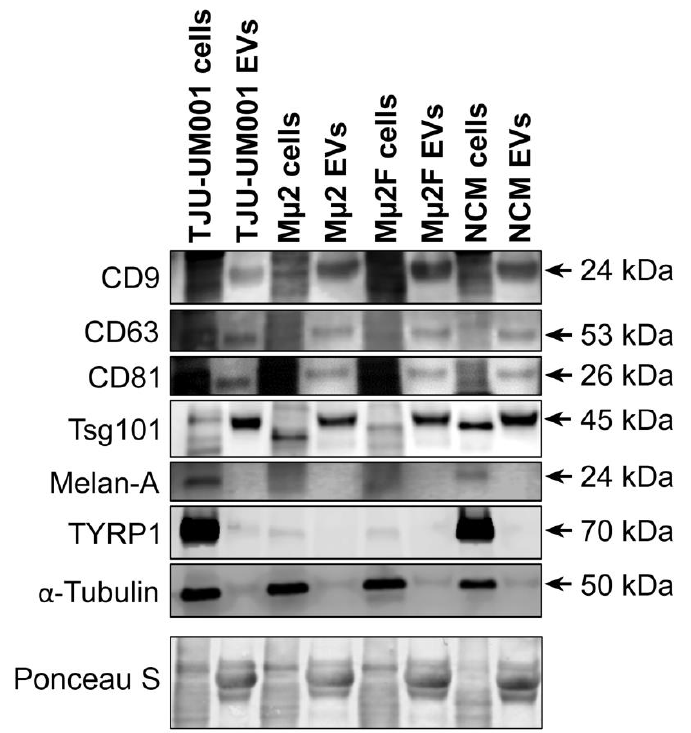
Figure 3. Exosomal and melanocytic markers present in UM-derived EVs. Cell pellets and EV fractions isolated from UM cell lines TJU-UM001 (metastatic), M µ 2 (non-metastatic), and M µ 2F (metastatic), or NCMs, were analyzed for their expression of exosomal (CD9, CD63, CD81, Tsg101) or melanocytic (Melan-A, TYRP1) markers by Western blotting. The anti- α -tubulin was used as marker of cytosolic proteins. Ponceau S staining was used as a loading control. Arrows indicate the specific band for each marker.